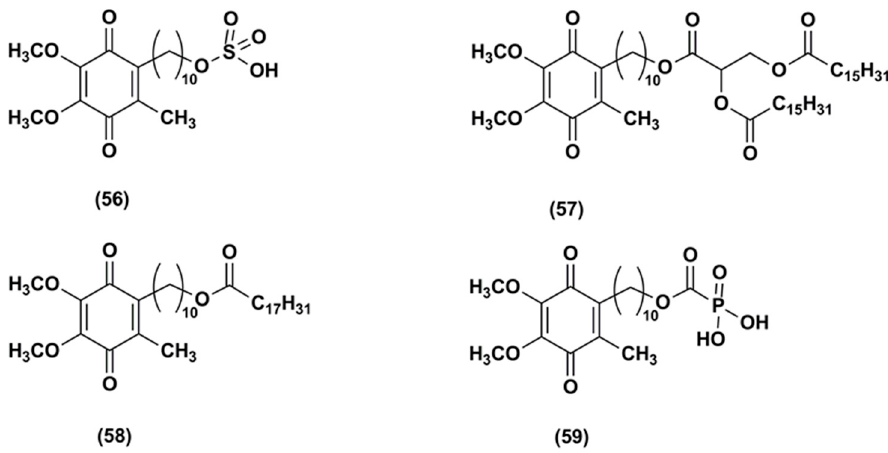
Figure 8. Chemical structures of carboxylic acid-substituted IDE derivatives.